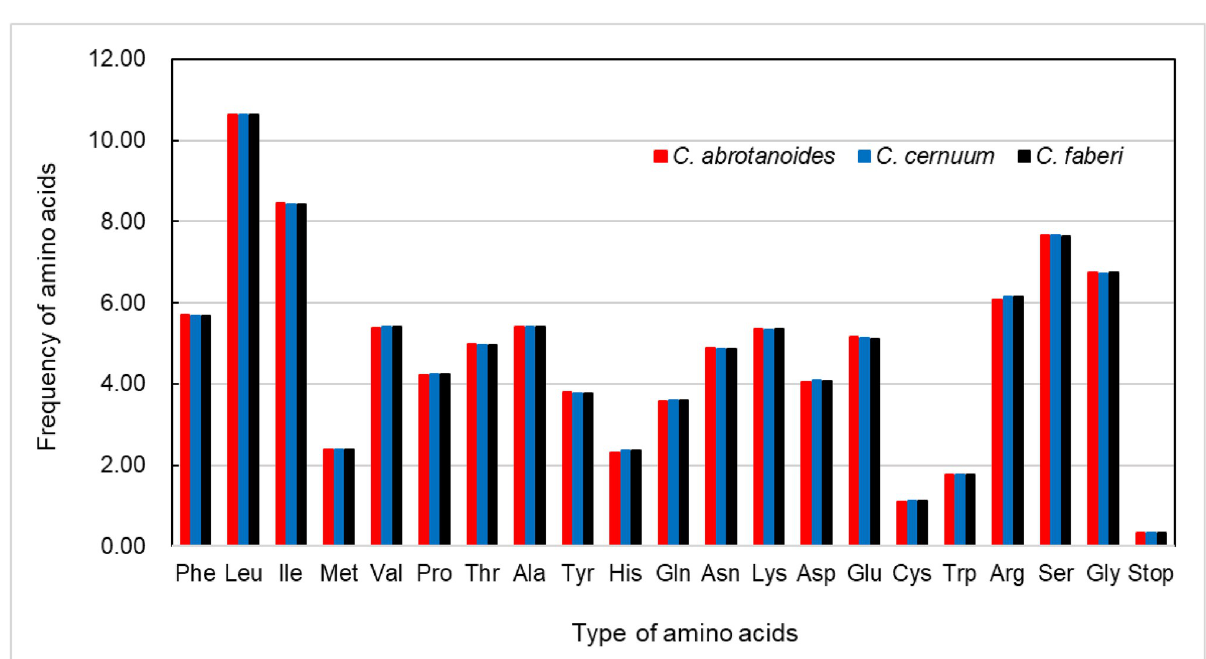
Fig 2. Comparison of amino acid frequencies in the cp genomes of three Carpesium